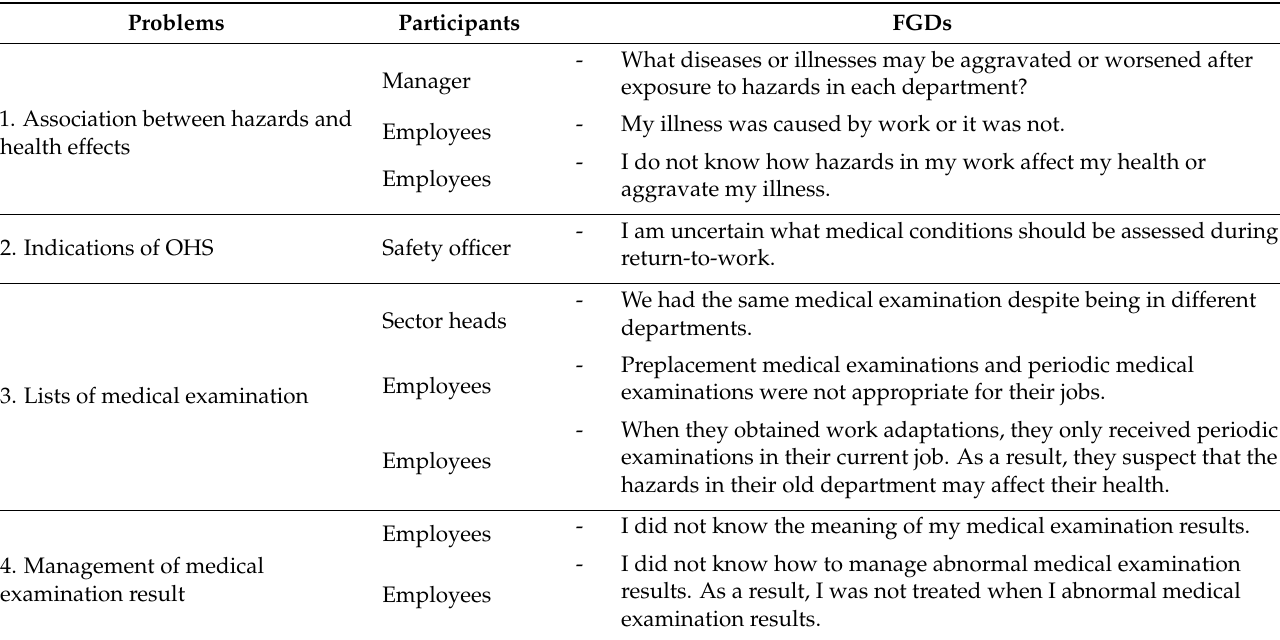
Table 7. The process of problems and causes